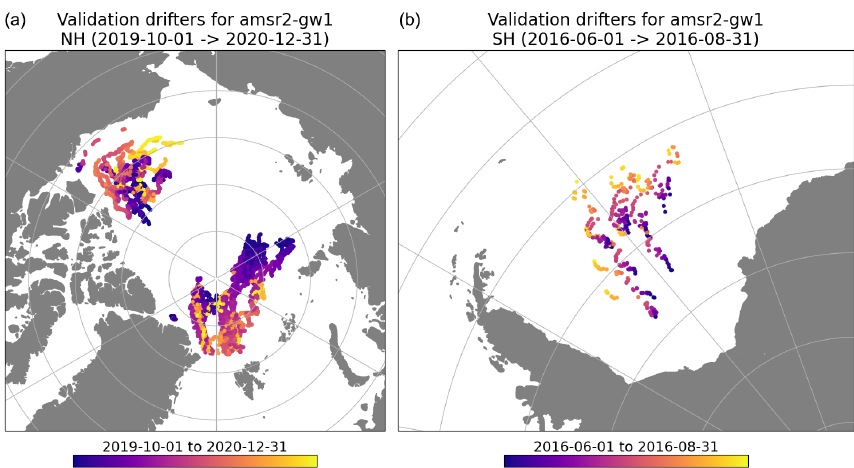
Figure 1. Location of on-ice drifter trajectories accessed for the validation of the sea-ice drift vectors in the Northern Hemisphere (a) and Southern Hemisphere (b) . The colours represent the time along the trajectory within the 15-month period (NH, Northern Hemisphere) and 3-month period (SH, Southern